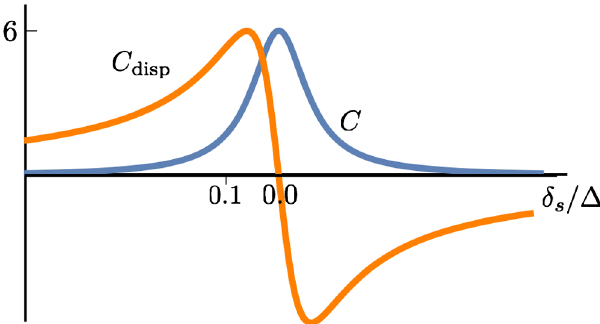
FIG. 3. ‘ The single-atom cooperativity C and the dispersive cooperativity C as a function of the detuning δ between the s disp squeezing and the dipole transition frequencies, normalized by the squeezing bandwidth Δ . The squeezing parameter s ð ω is set s Þ to give 23 dB squeezing, and 50% losses are included. Note that the Lorentzian profile of the squeezing spectrum inevitably leads to an enhanced